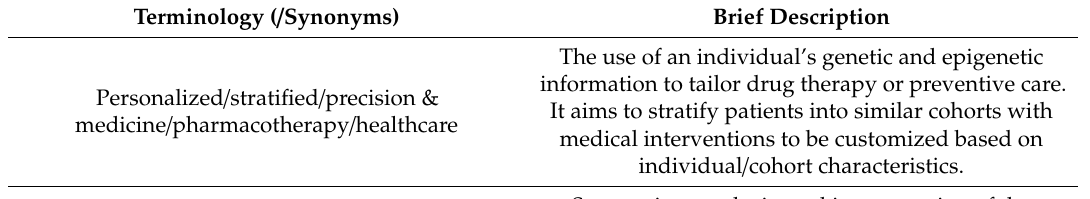
Table 1. A brief list of basic terminologies that NP should be aware of since they are often used in clinical practice of